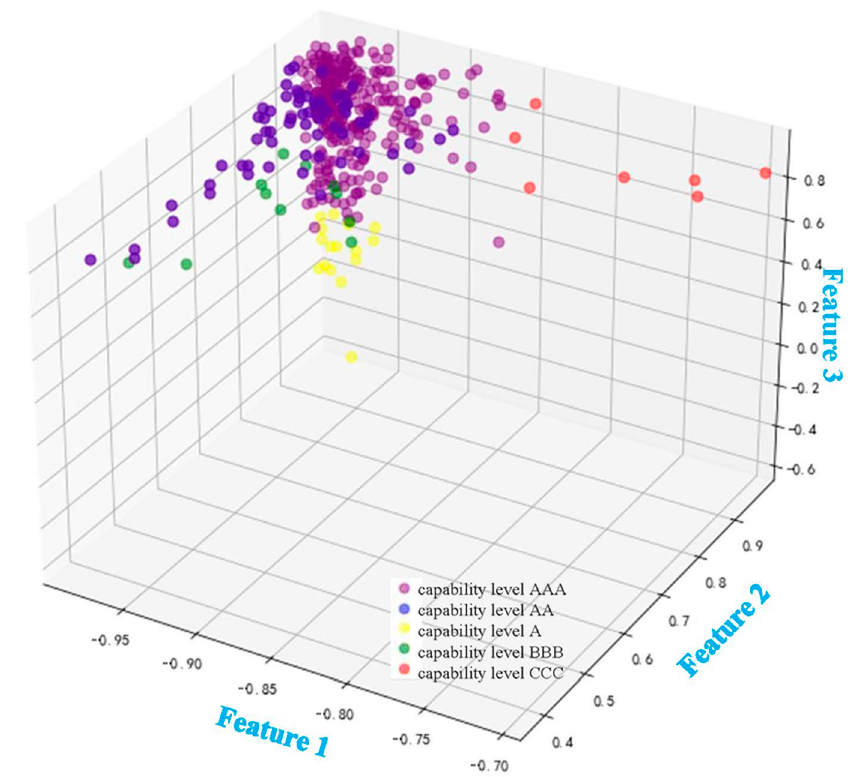
Figure 5. Distribution of capability sequence characteristics.